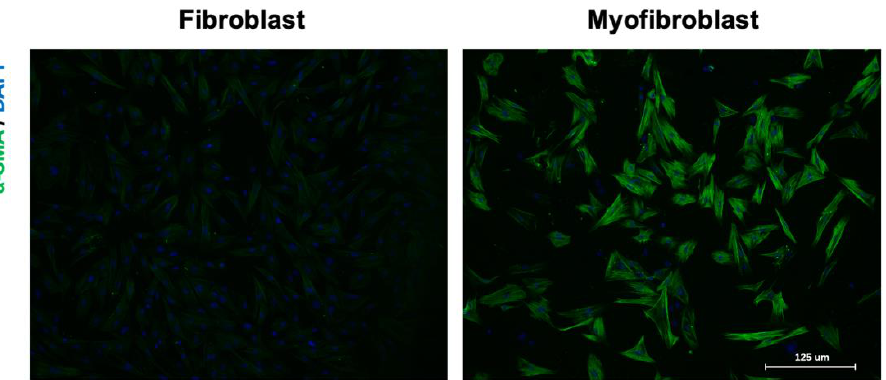
Figure 2. Fibroblast-to-myofibroblast transition. Primary cells were stained with anti- α SMA antibody (green), and cell nuclei were stained with 4 (cid:48) ,6-diamidino-2-phenylindole